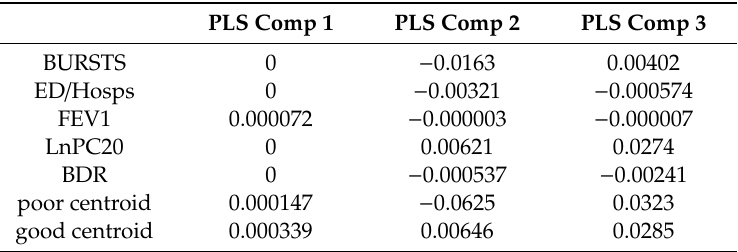
0 poor centroid good centroid 0.000339 0.00646